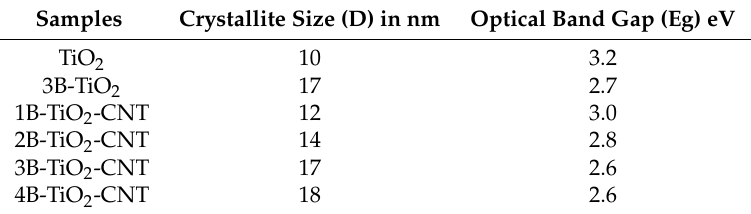
Figure 1. XRD patterns of TiO 2 , 3B-TiO 2, and B-TiO 2 -CNT nanocomposites. Table 1. Crystallite size and optical bandgap of synthesized